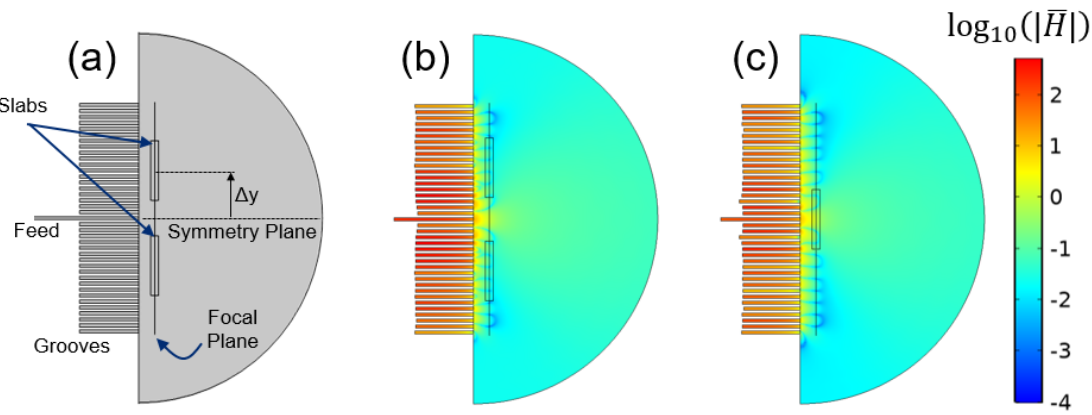
Figure 5. ( a ) Geometry for the inhomogeneous focusing study, with two blocks having n = 2. ( | H z | ) , for ∆ y = 0.65 and ∆ y = 0, respectively. ( b,c ) Spatial distribution of the magnetic fields, log 10 Note that the groove depths have changed, but the focused field remains the same.